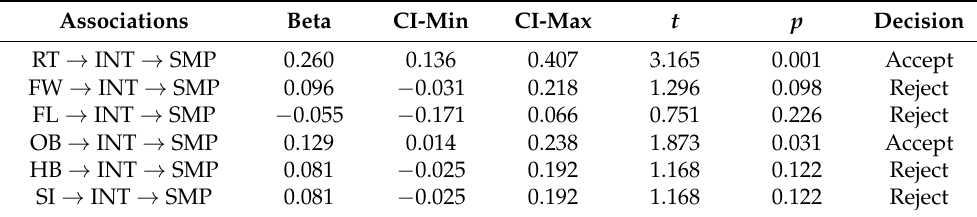
Table 6. Mediating